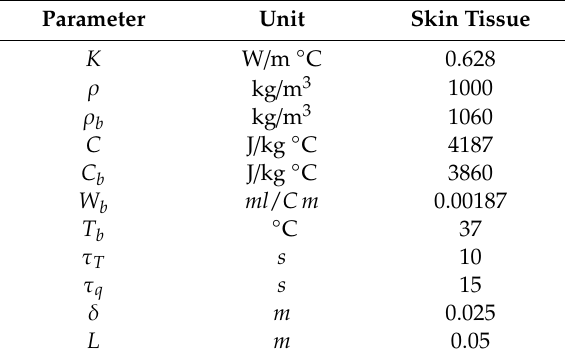
Table 1. Material properties of the skin tissue employed.